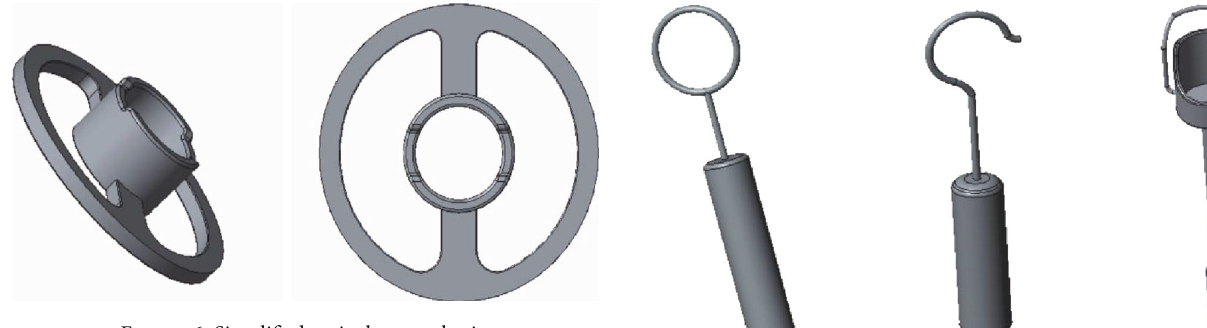
Figure 6: Simpli fi ed ossicular prosthesis.